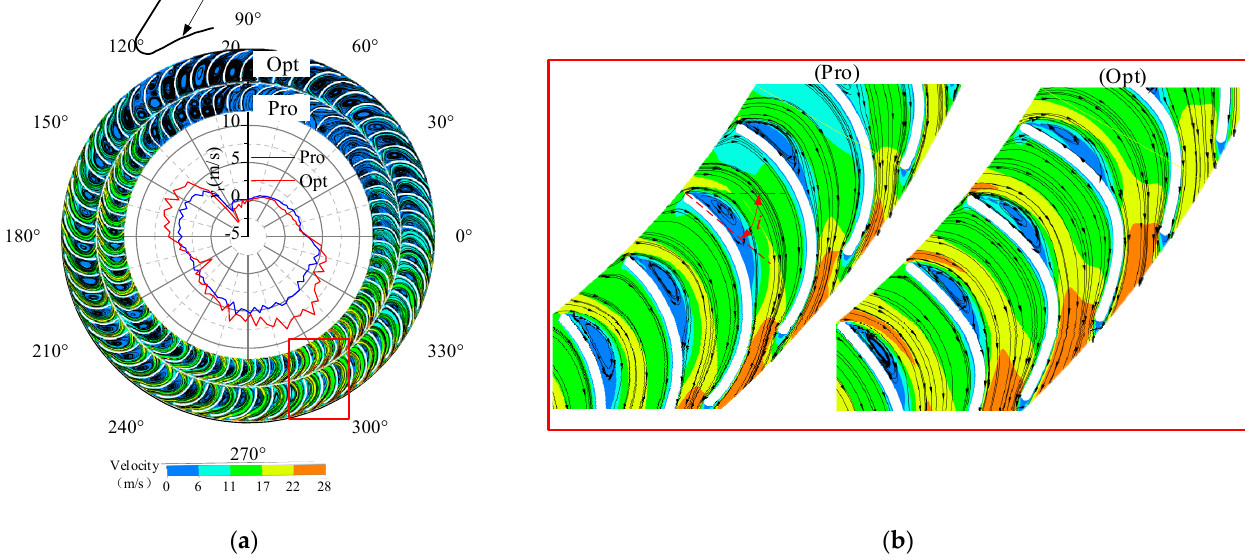
Figure 17. Comparison of velocity distribution in the middle section: ( a ) the radial velocity at the exit of the impeller inside and the velocity distribution and streamline diagram outside; ( b ) the partial enlargement of the velocity distribution and streamline diagram.